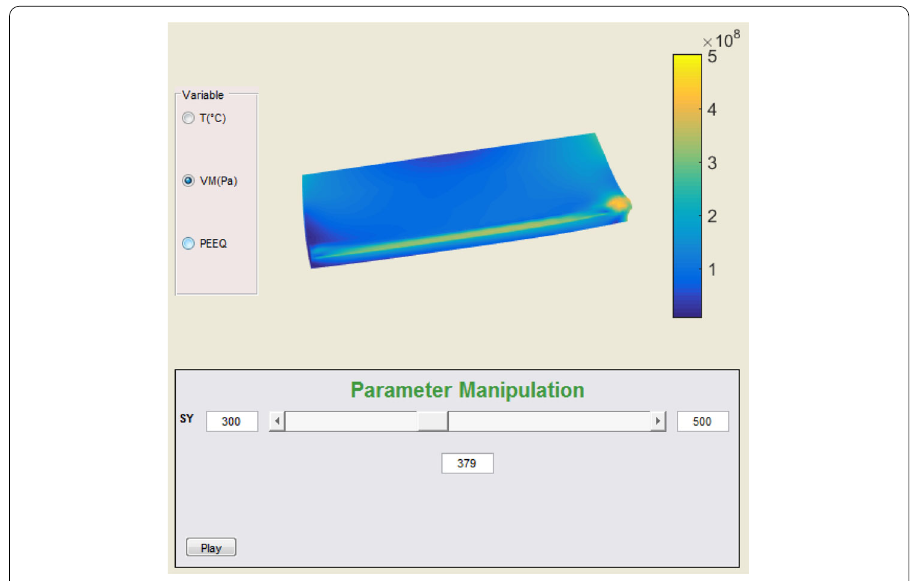
Fig. 13 Space–time yield stress computational vademecum